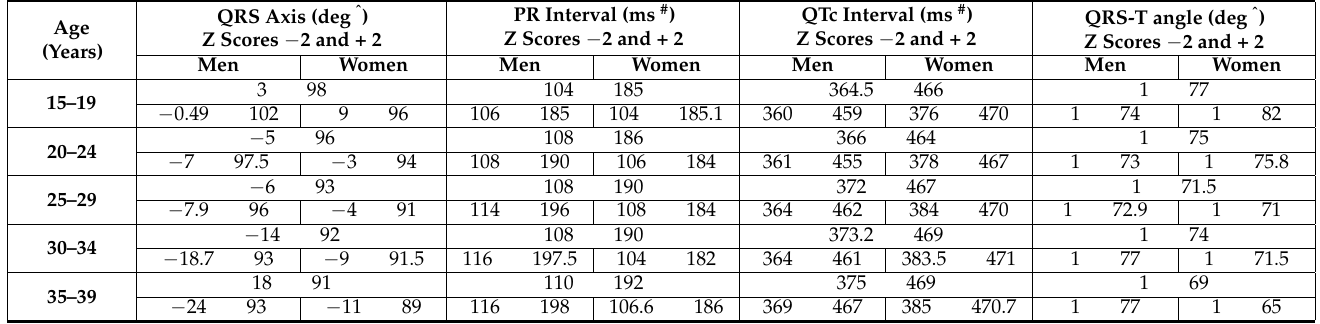
Table 4. Z-scores − 2 and +2, computed in 15 age categories of 5 years each, of the three parameters with a straight-line correlation with age and of QRS-T angle. On each cell Z-scores − 2 (on the left) and +2 (on the right). For each age category, in the upper line, − 2 and + 2 Z-scores in the whole population; in the bottom line, − 2 and + 2 Z-scores in males and